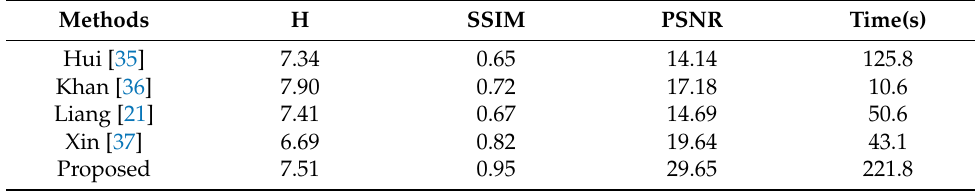
Table 3. Objective values of the images shown in Figure